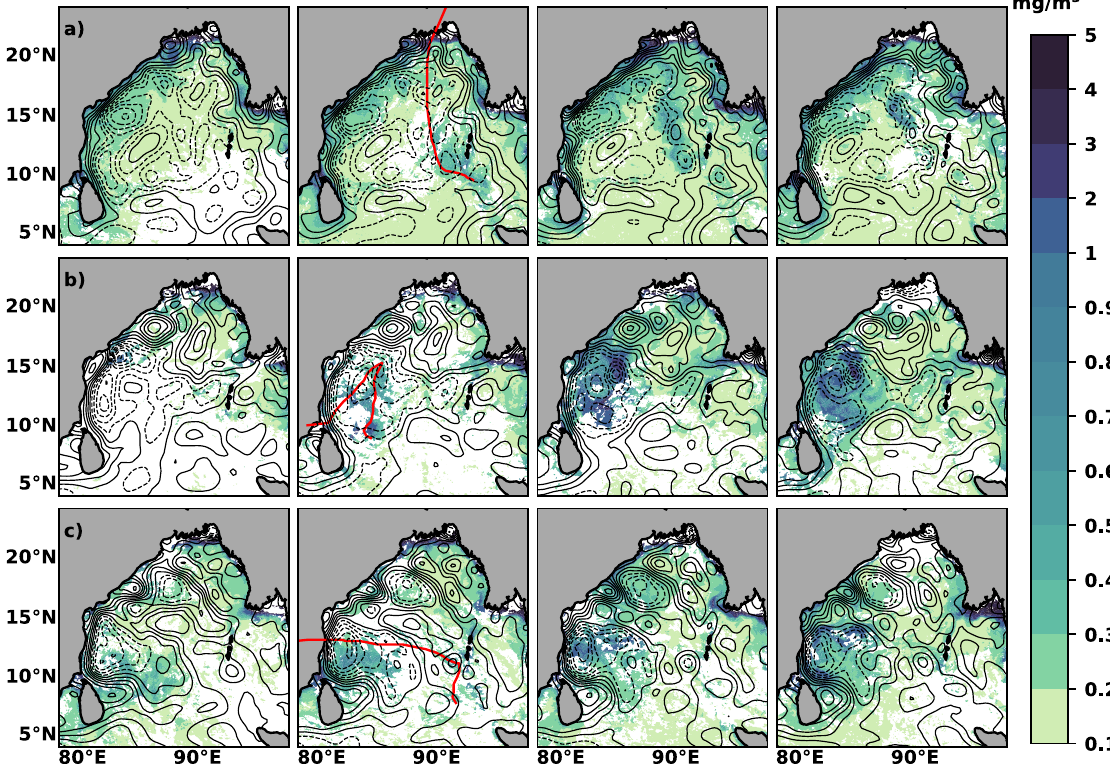
Fig. 3 The spatial extension of Chl-a bloom for selected post-monsoon cyclones in BoB. The Chl-a averaged, overlaid with SSHA contours (solid — positive and dashed — negative), for 5 days before cyclone, during the entire cyclone period, fi ve days just after the passage of cyclone and next 5 days for a Sidr (2007), b Madi (2013), and c Vardah (2016). The tracks of the respective cyclones are also